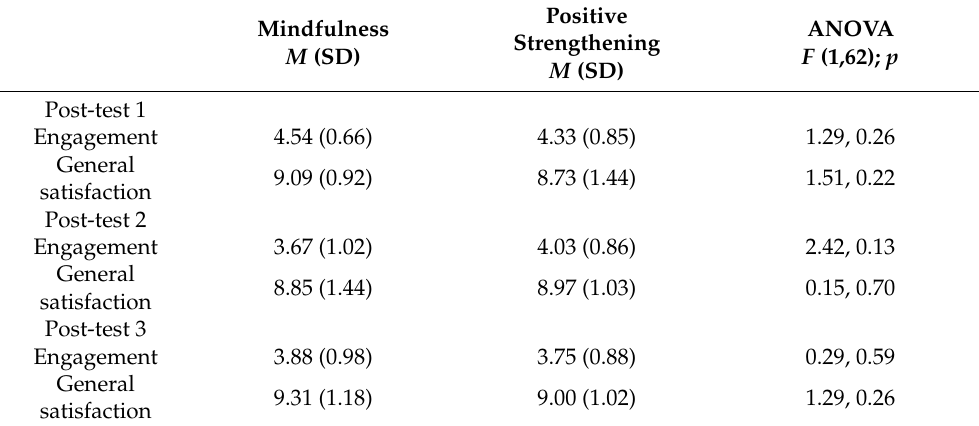
Table 3. Levels of engagement and general satisfaction for both intervention